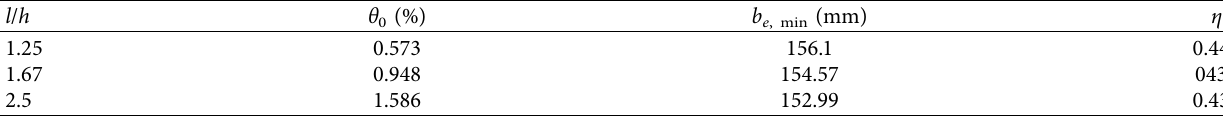
Figure 20: Effective width of core walls with varied span-depth ratios. Table 4: Minimum effective width of core walls with varied span-depth ratios.